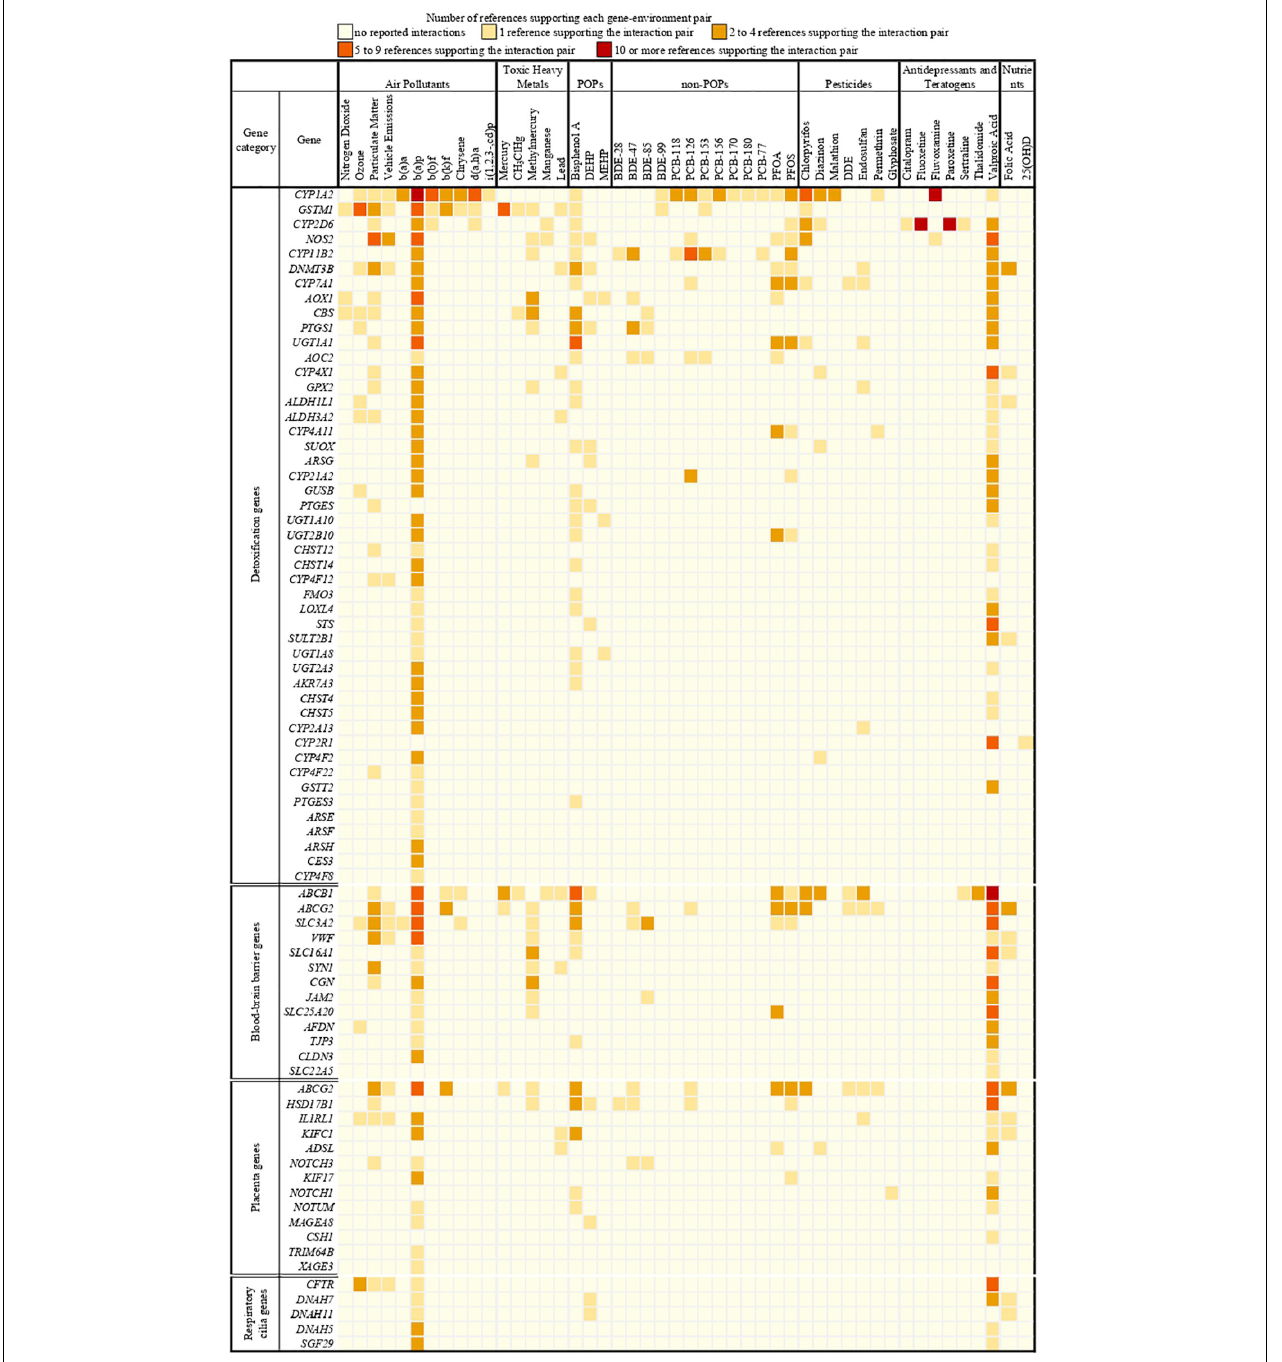
FIGURE 3 | Heat map showing the gene-environment interactions pairs identified through the Comparative Toxicogenomics Database. Shown are the 397 gene-environment interaction pairs, between the 77 high evidence XenoReg genes and the 60 individual xenobiotics, identified through the CTD query. The colors represent the amount of published references supporting each interaction pair (darker colors are for high numbers of supporting references, while lighter colors are for low numbers of supporting references). Xenobiotics that do not interact with any of the 77 high evidence XenoReg genes are not shown. 25(OH)D, 25-hydroxyvitamin D; b(a)a, b(a)p, b(b)f, b(k)f, d(a,h)a and i(1,2,3,-cd)p are Polycyclic Aromatic Hydrocarbons (see Supplementary Table 2 ); BDE28, BDE47, BDE85, and BDE100 are congeners of Polybrominated diphenyl ethers (see Supplementary Table 2 ); CH 3 ClHg, Methylmercuric chloride; DDE, Dichlorodiphenyldichloroethylene; DEHP, Diethylhexyl phthalate; MEHP, Mono-(2-ethylhexyl)phthalate; non-POPs, non-Persistent Organic Pollutants; PCB118, PCB126, PCB153, PCB156, PCB170, PCB180, and PCB77 are congeners of Polychlorinated biphenyls (see Supplementary Table 2 ); PFOA, Perfluorooctanoic acid; PFOS, Perfluorooctane sulfonic acid; POPs, Persistent Organic Pollutants.